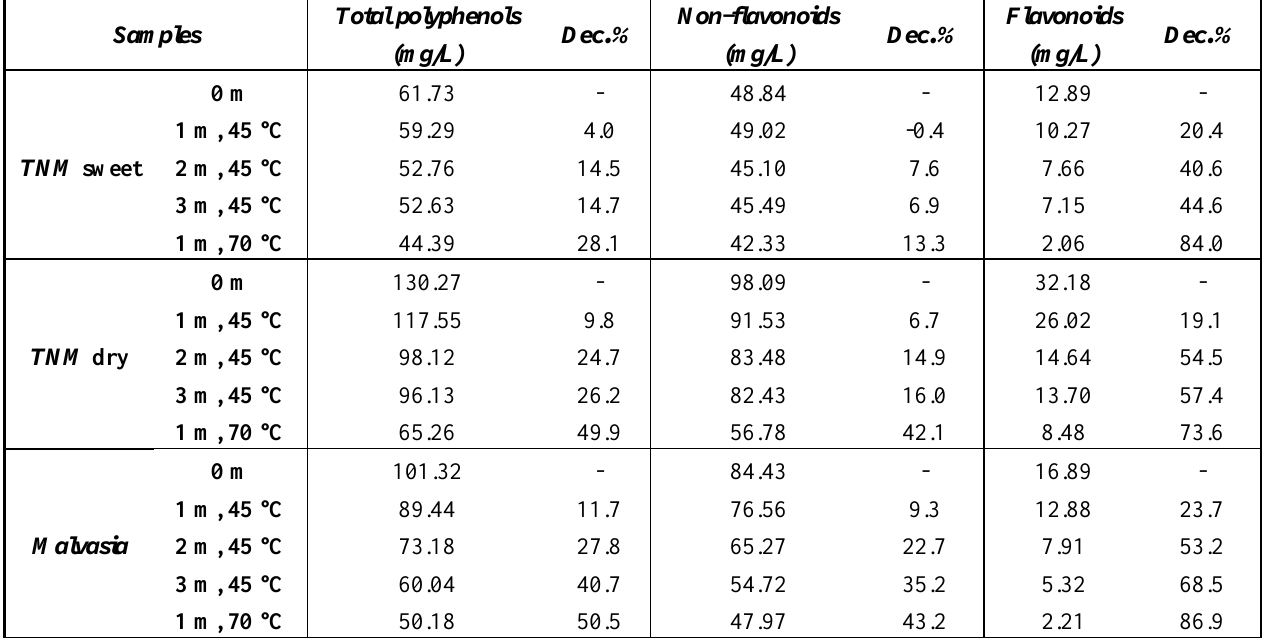
Table 5. Total of polyphenols (mg/L) during the heating at 45 °C (3 months) and 70 °C (1 month) of the studied Madeira wines, regarding HPLC-DAD